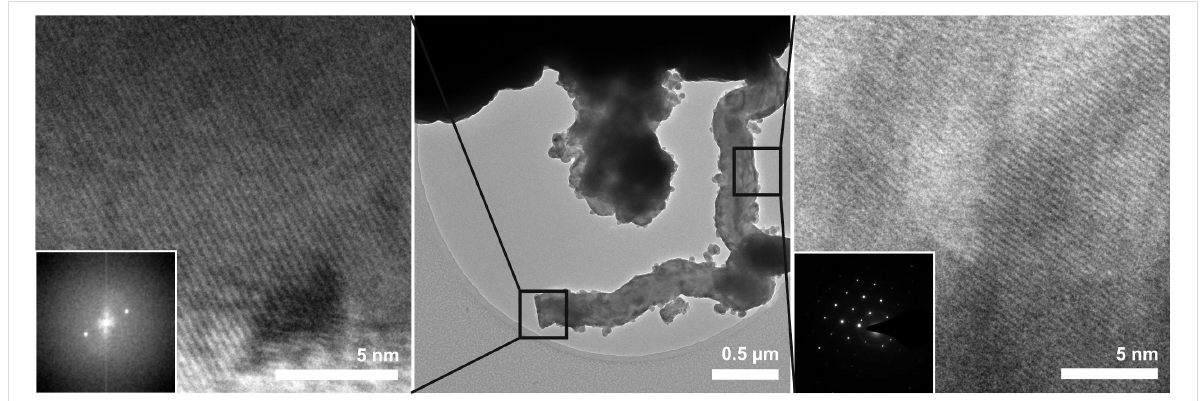
Figure 3: TEM images of NWs grown on gold-sputtered Si[111] for 1 h at 375 °C. The FFT of the HRTEM image and the SAED pattern indicate the crystallinity of the Si NWs.